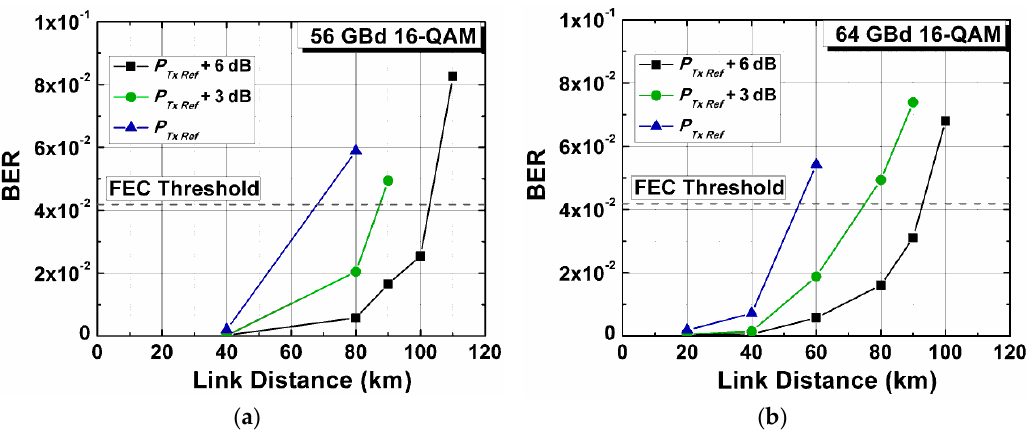
Figure 5. Bit error ratio (BER) as a function of transmission distance in unamplified point-to-point link for ( a ) 56 GBd 16-QAM signals; ( b ) 64 GBd 16-QAM signals.